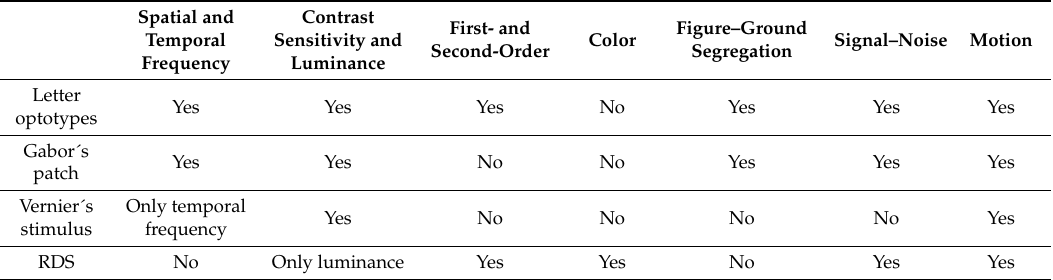
Table 2. Parameters that could be modified according to the type of stimulus in vision training for amblyopia.